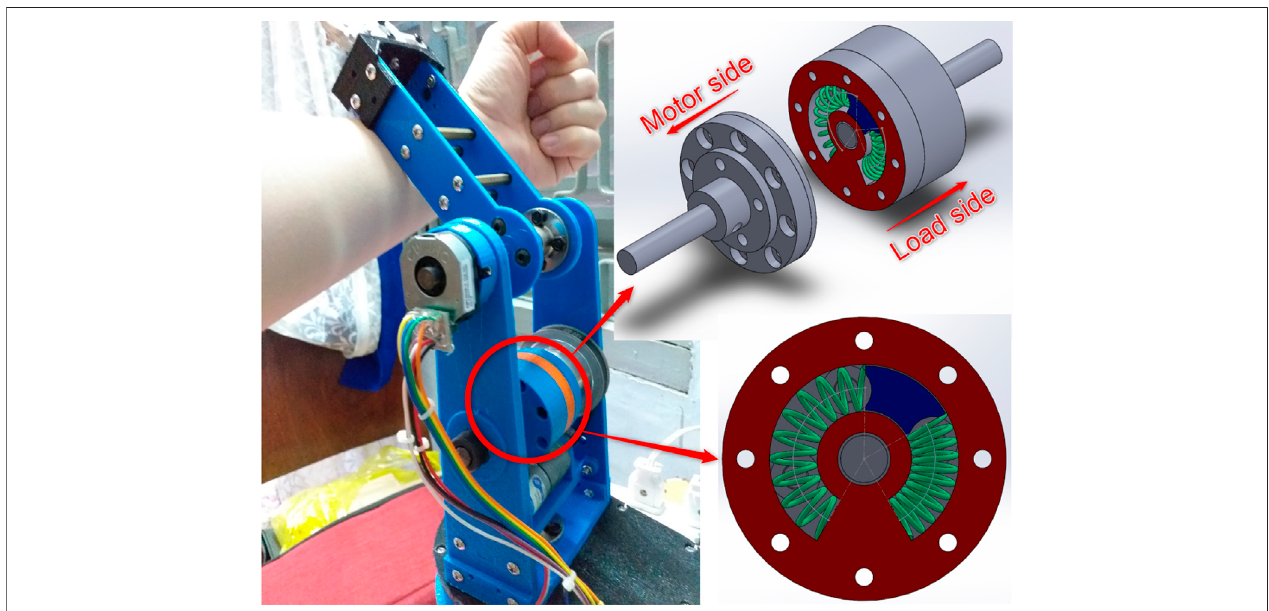
FIGURE 1 | The proposed 2-DOF robot arm with elastic joints for safe human-robot interaction. The real 3D-printed prototype and the 3D model of the joint are shown, respectively.